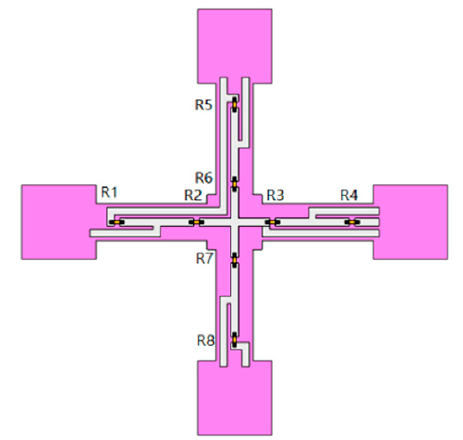
Figure 1. Diagram of piezoresistors on crossbeam.